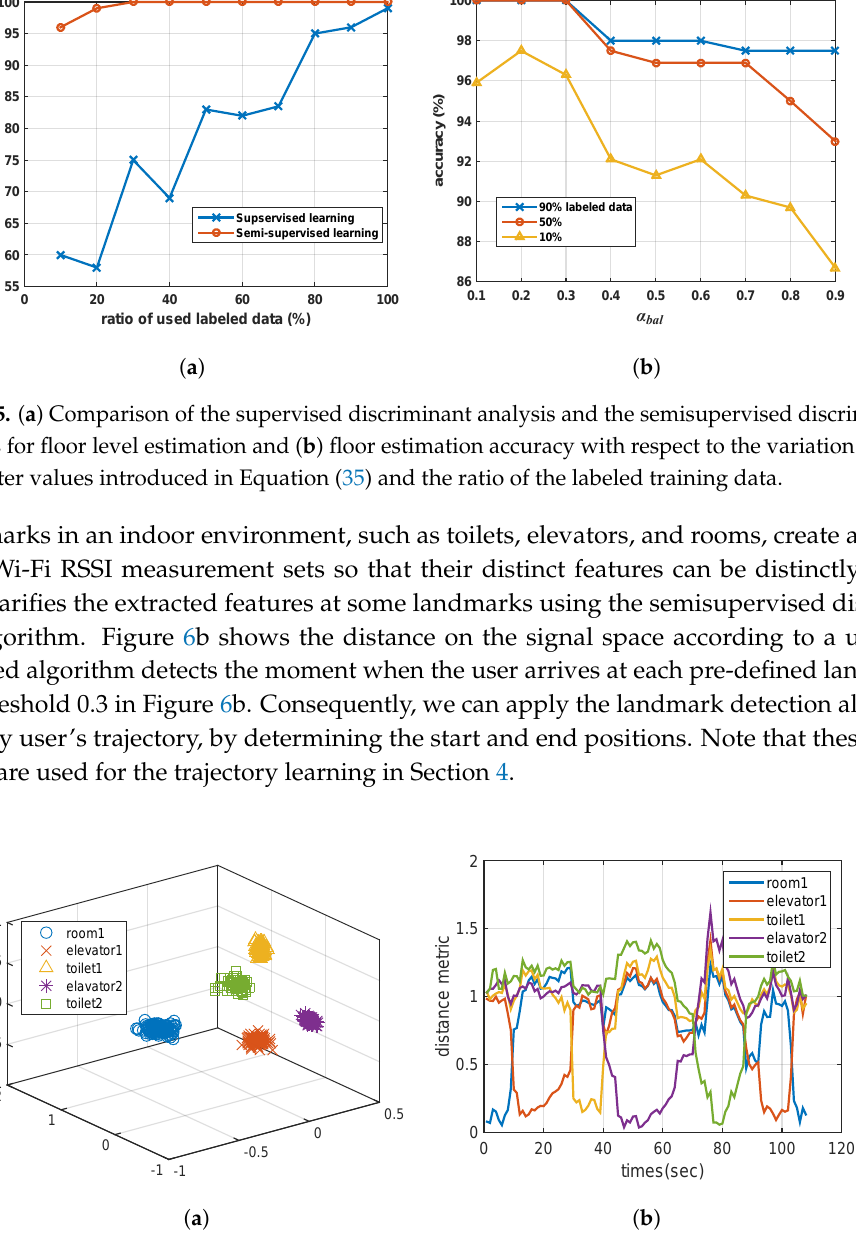
Figure 6. ( a ) Result of feature extraction from dataset on the landmarks. ( b ) Variation of the distance metric D c in Equation (36), corresponding to a user’s movement in the following order; room 1 → elevator 1 → toilet 1 → elevator 2 → toilet 2 → elevator 1 → room 1